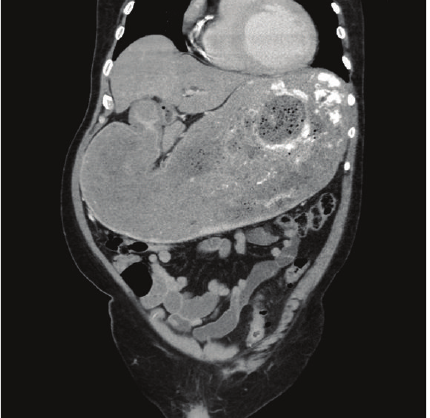
Figure 4: Sagittal view showing massive gastric distension with no passage of oral contrast beyond the gastric fundus. The visualized loops of bowel are